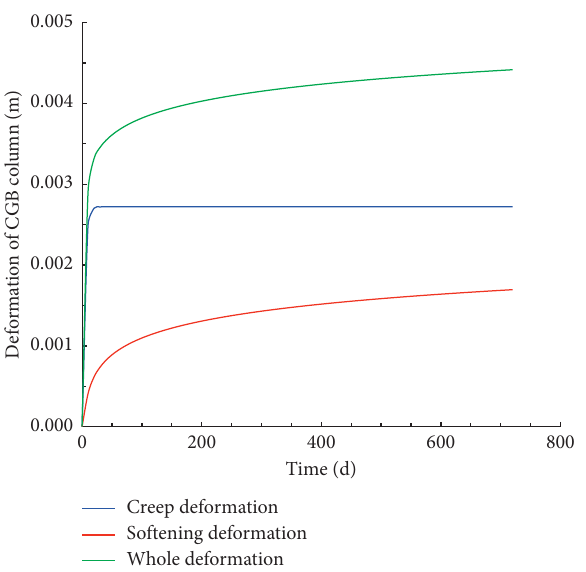
Figure 10: Effect of AMD corrosion on creep deformation of